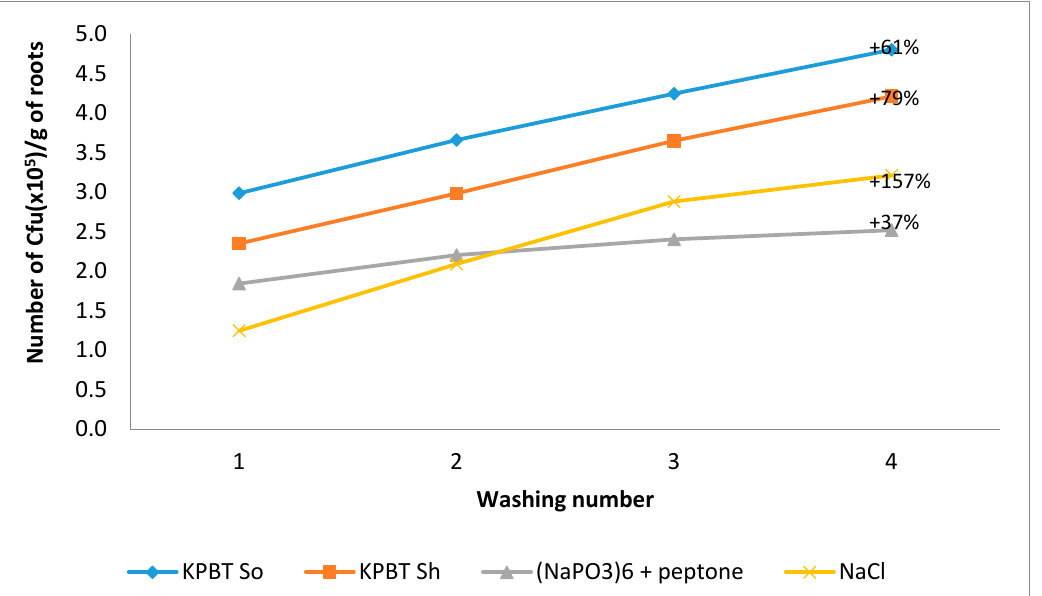
Figure 4. Mean of the cumulative number of CFU per gram of roots for bacteria counted in the four successive washes for each protocol (KPBT So, KPBT Sh, (NaPO 3 ) 6 + Peptone and NaCl). The percentages on each graph represent the percentage increase of the sum of the four washes compared with the first.